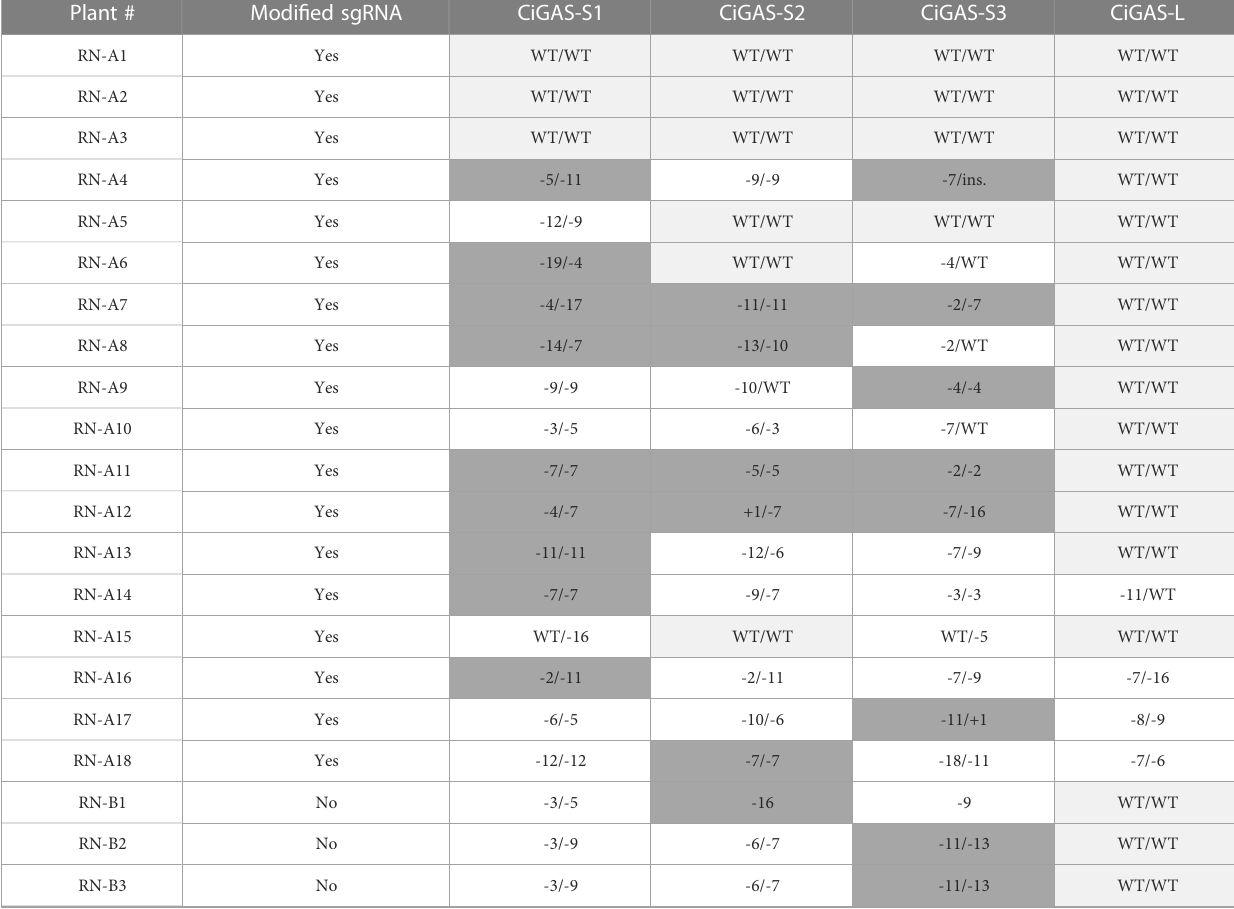
TABLE 1 CiGAS genotype of the plants regenerated from protoplasts transfected with RNPs. Plant